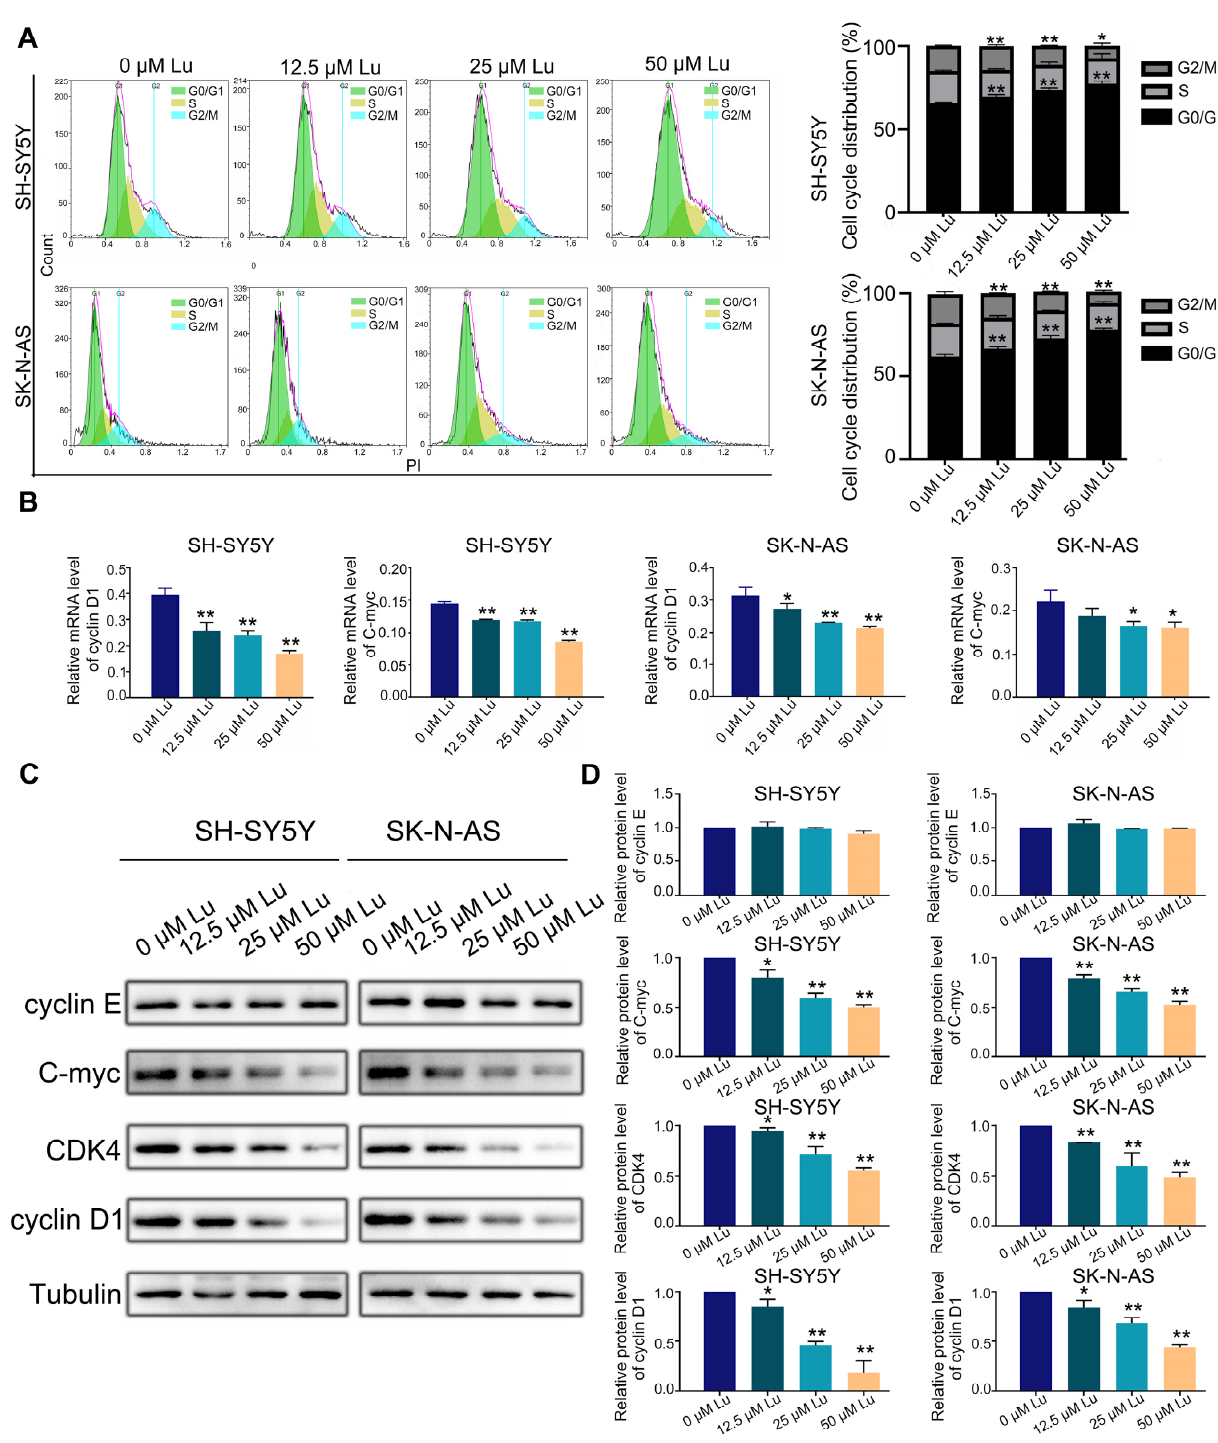
Figure 3. Luteoloside induces neuroblastoma cell cycle arrest. SH-SY5Y and SK-N-AS cells were treated with varying concentrations (0, 12.5, 25, and 50 μ M) of luteoloside for 24 h. ( A ) The SH-SY5Y and SK-N-AS cell cycle distributions were measured by flow cytometric analysis. ( B ) The protein expressions of cyclin D1, cyclin E, C-myc, and CDK4 were tested by Western blot. ( C ) Statistical analysis of the expression intensity of cyclin D1, cyclin E, C-myc, and CDK4 in SH-SY5Y and SK-N-AS cells. Tubulin is taken as internal reference. ( D ) The relative mRNA expression of cyclin D1 and C-myc in SH-SY5Y and SK-N-AS cells was analyzed using qRT-PCR. *, p < 0.05; **, p < 0.01. n = 3. The control group is used for comparison. Data are shown as mean ±